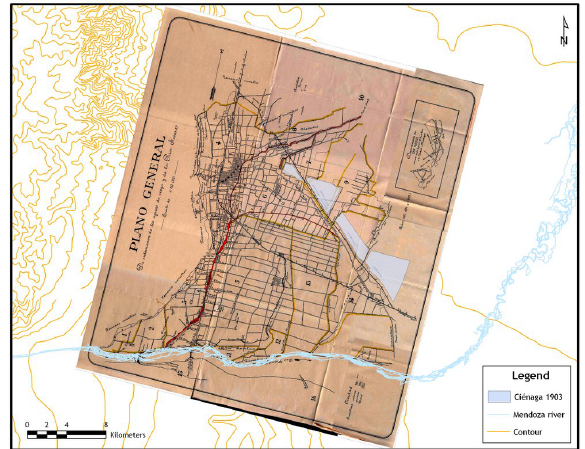
Fig. 9. The Bermejo Wetland in 1903 according Pedro Arata Map (Arata et al.,